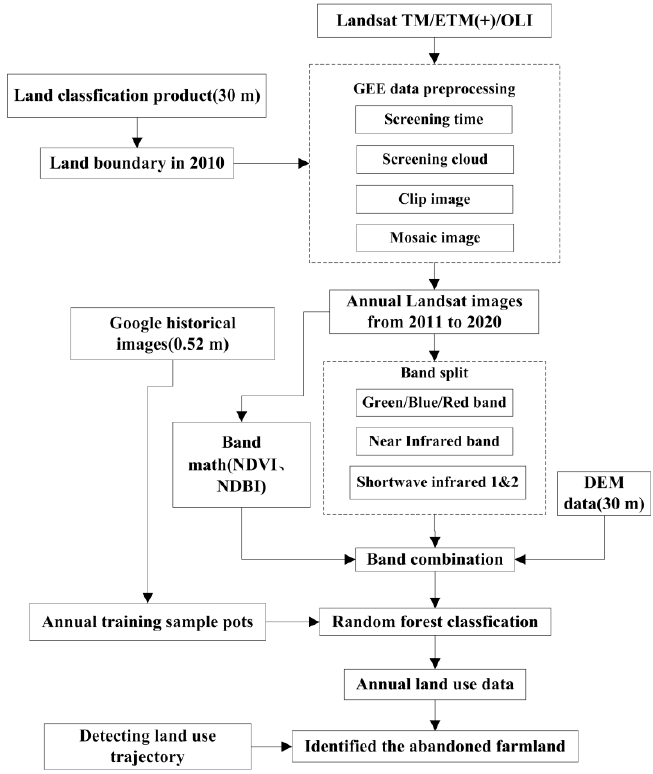
Figure 3. Technical route for abandoned cropland identification.